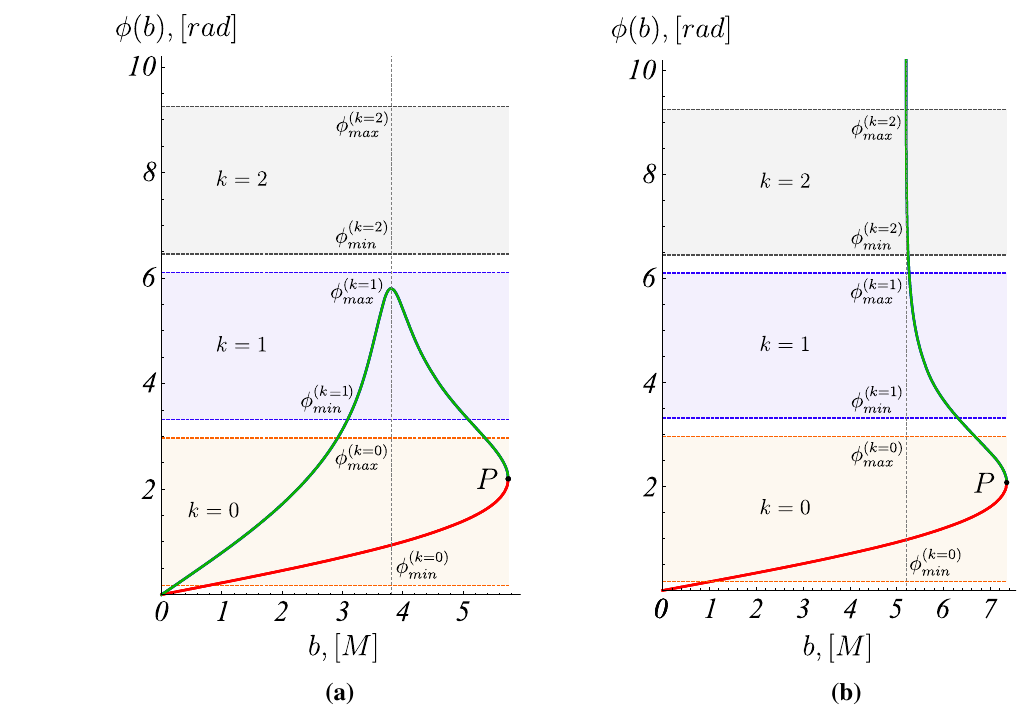
Fig. 7 Image formation diagrams for the outer marginally stable orbit r + = 5 . 896 M of the strongly naked singularity with γ = 0 . 48 ( a ) and for the ISCO of the Schwarzschild solution ( b ). The observer is located at r = 5000 M and at the inclination angle i = 80 ◦ . The point P represents the maximum value for the impact parameter b max , for which we reach the critical azimuthal angle φ crit . The main distinc- tion between the two cases is that for the strongly naked singularity the Fig. 8 Image formation diagram for the outer marginally stable orbit r + = 5 . 896 M of the strongly naked singularity with γ = 0 . 48 . ( a ) and the corresponding observable image ( b ). We use the same conventions as in Fig.